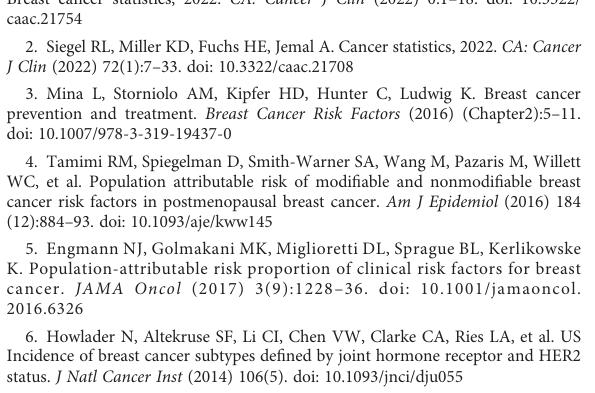
SUPPLEMENTARY TABLE 3 Characteristics of SNPs associated with telomere length and the prognosis of ER+ breast cancer. SUPPLEMENTARY FIGURE 1 Sensitivity analysis based on leave-one-out analysis. SUPPLEMENTARY FIGURE 2 Funnelplot toassess therobustnessof results.Scattering points represent the effect estimated using a single SNP as an instrumental variable. Vertical lines denote the overall estimate obtained by the inverse variance weighted estimate and the MR-Egger